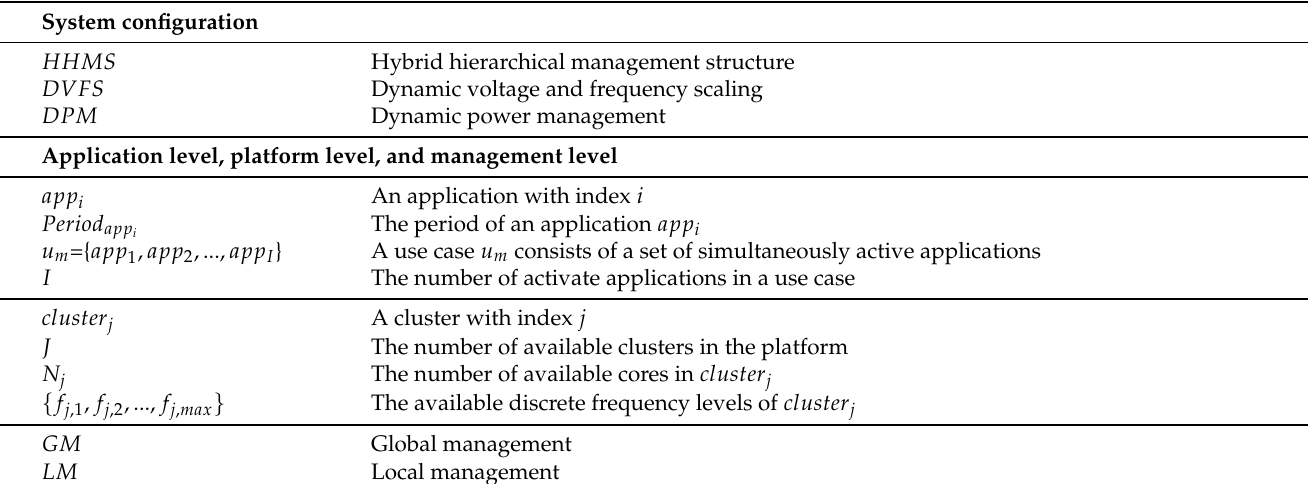
Table 2. Notations used in this